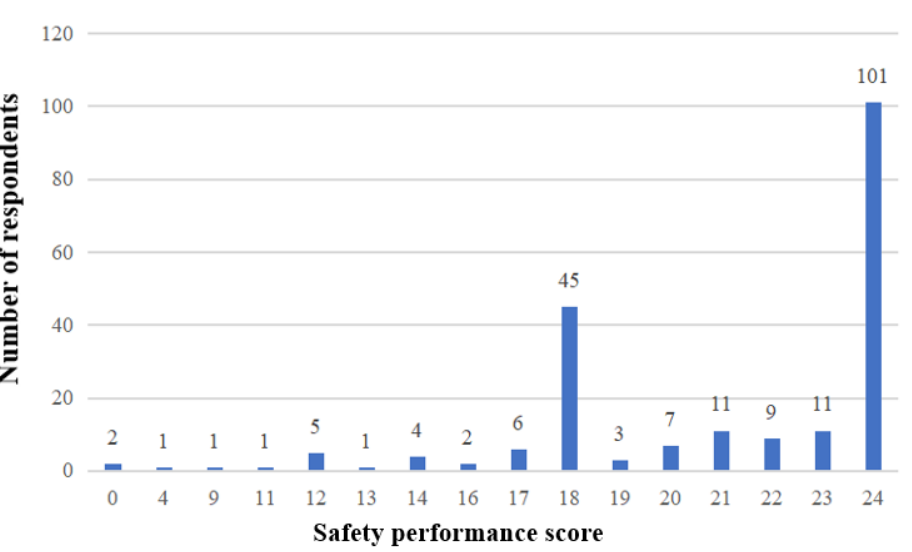
Figure 1. Distribution of safety performance score.